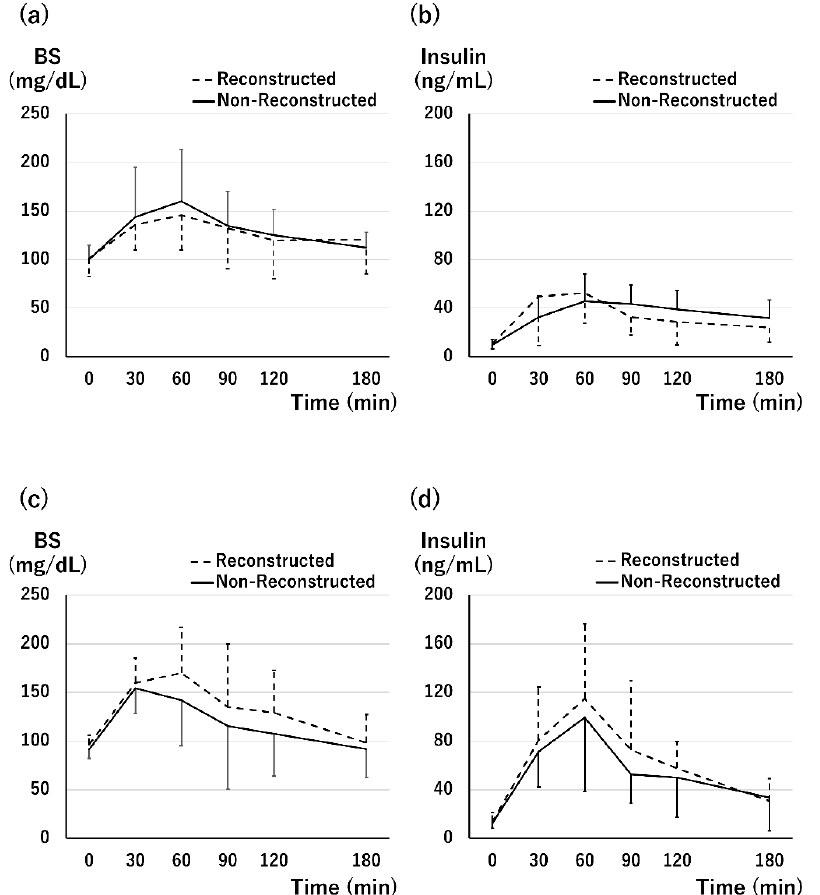
Figure 6. Results of oral glucose tolerance test. ( a ) Change in the blood glucose (BS) level at 1 month after transplantation: BS transition of both the groups was not significantly different during the test. The area under the curve (AUC) of BS level during the test was comparable between the two groups (the non-reconstructed group vs. the reconstructed group; 385.4 (321.6–424.6) vs. 365.4 (351.3–426.3), p = 0.82). ( b ) Change in the insulin level at 1 month after transplantation: The insulin peak was 30 min in the reconstructed group and 60 min in the non-reconstructed group. There was no significant difference in the value during the examination. The AUC of insulin level showed no difference between the two groups (the non-reconstructed group vs. the reconstructed group; 120.1 (80.9–139.8) vs. 106.8 (65.7–131.4), p = 0.67). ( c ) Change in the BS level at 1 year after transplantation: Both the groups showed sufficient BS transition. There was no significant difference in the values during the examination. The AUC of BS level during the test was comparable between the two groups (the non-reconstructed group vs. the reconstructed group; 331.3 (287.3–366.1) vs. 370.5 (343.0–488.4), p = 0.28). ( d ) Change in the insulin level at 1 year after transplantation: The changes in BS and insulin levels in both the groups were similar during test times. There was no difference in the peak insulin time between the two groups. The AUC of insulin level showed no difference between the two groups (the non-reconstructed group vs. the reconstructed group; 168.3 (112.8–194.8) vs. 186.7 (158.1–189.7), p =